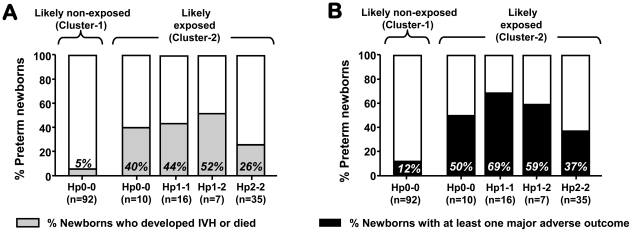
Relationships among cluster assignment, cord blood haptoglobin (Hp) phenotype at birth and composite outcome indicators.The percentages and the height of the grey or black portion of the bar indicate the proportion of newborns displaying the adverse composite outcome “IVH or death” (A) or “at least one major adverse outcome” (B). Abbreviations: IVH, intraventricular hemorrhage; ROP, retinopathy of prematurity; NEC, necrotizing enterocolitis; BPD, bronchopulmonary dysplasia; EONS, early-onset neonatal sepsis; IAI, intra-amniotic infection and/or inflammation.